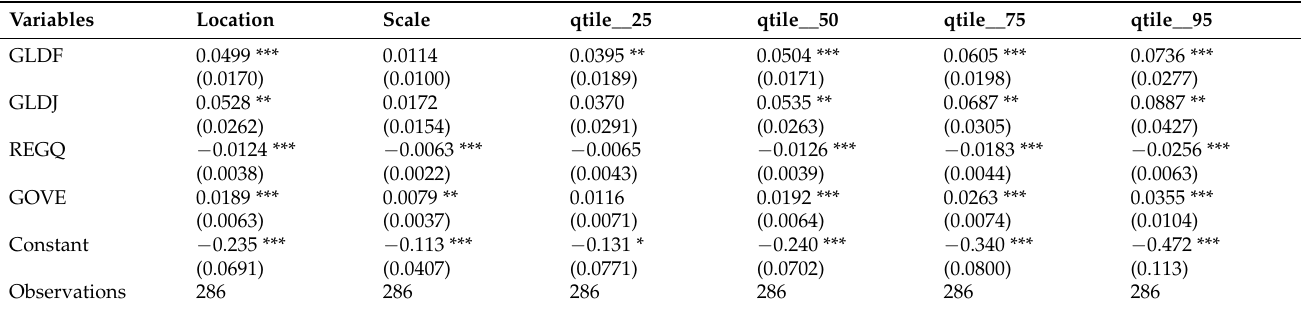
Table 6. Model 4. DV: Income Share of the Bottom 60% (IN3).